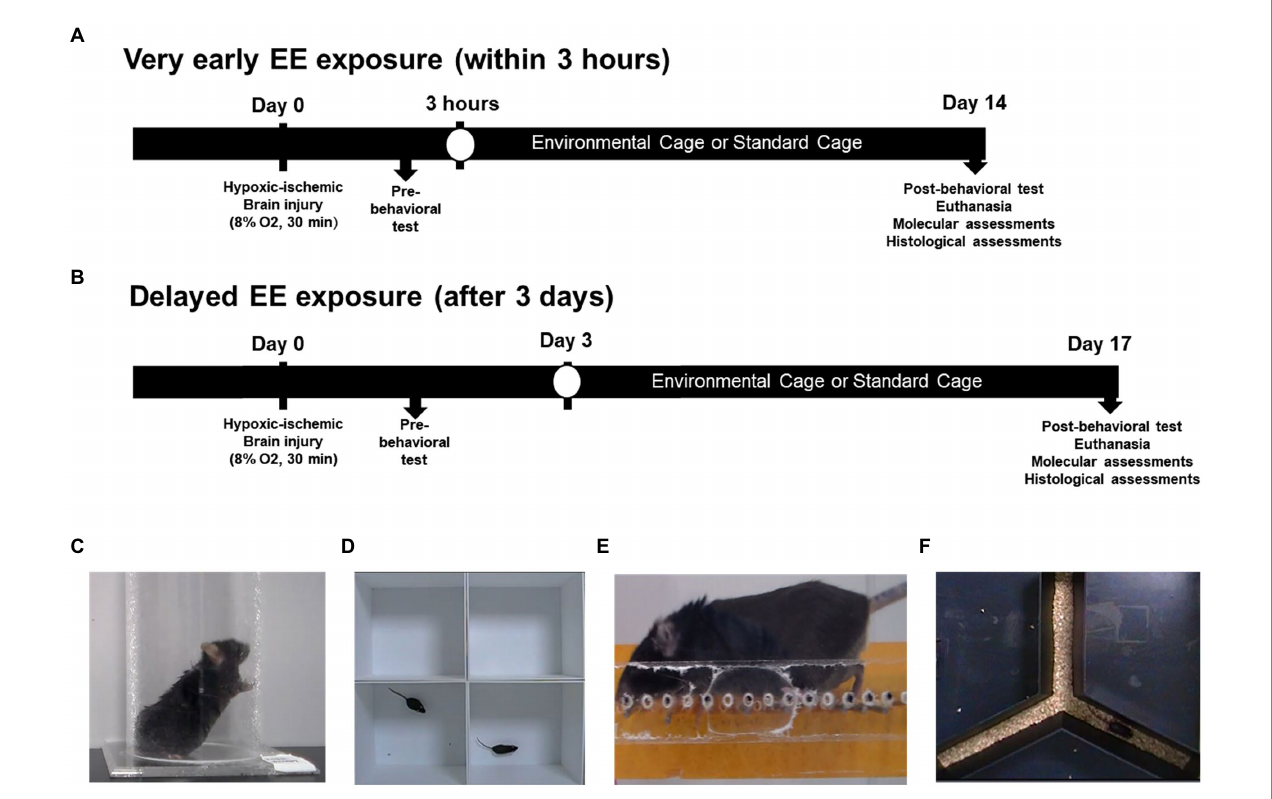
FIGURE 1 Schematic overview of the experimental design and behavioral assessments. (A) Very early exposure to EE. Within 3 h after HI brain injury, mice were exposed to either EE or SC for 14 days. (B) Delayed exposure to EE. Three days after HI brain injury, mice were exposed to either EE or SC for 14